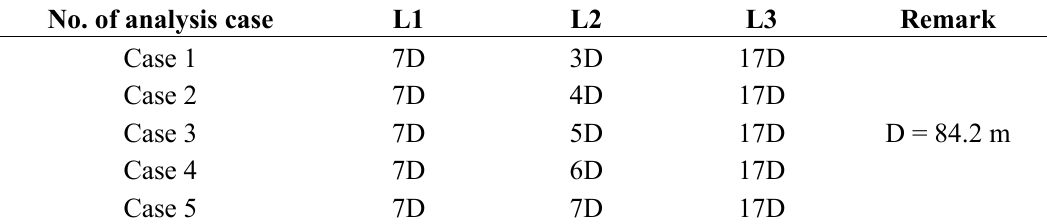
Table 1. Analysis cases according to inter-turbine